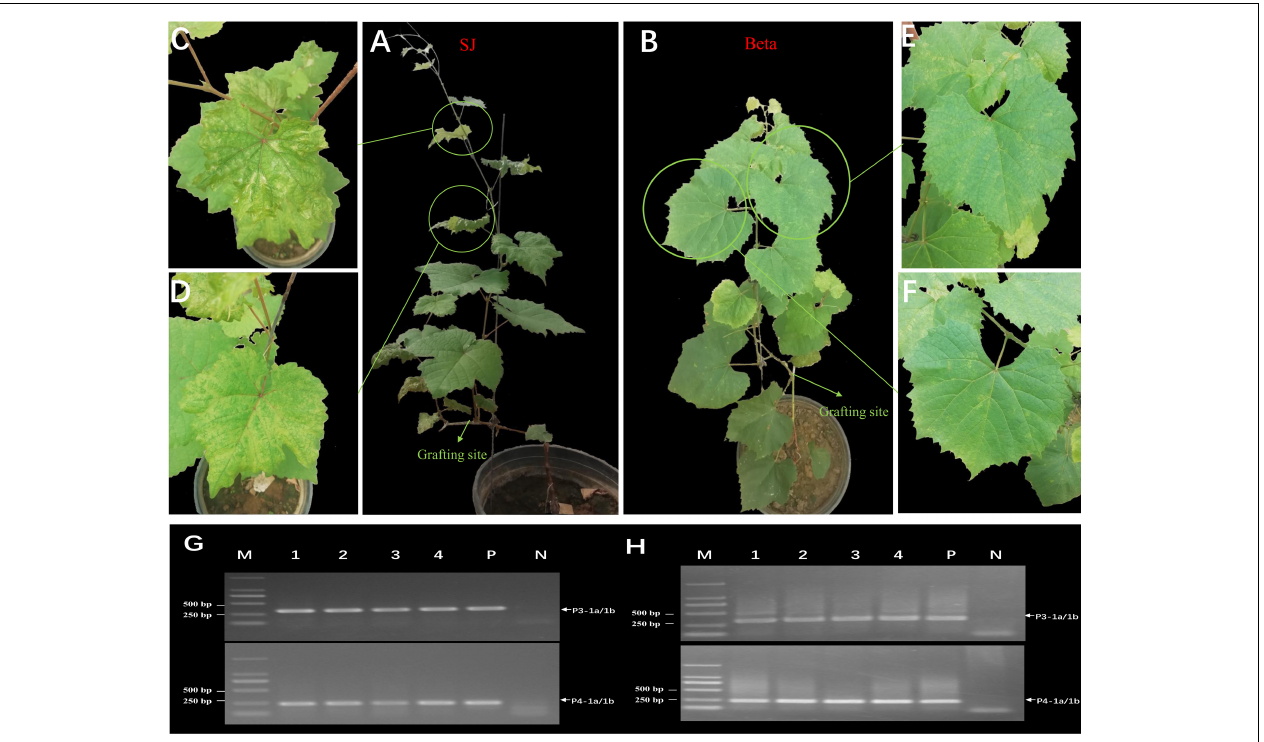
FIGURE 5 | Mechanical transmission of grapevine emaravirus A (GEVA) to grapevines. (A) Grafted “Shennong Jinhuanghou” (SJ) grapevine; (B) grafted “Beta” grapevine; Panels (C,D) partially enlarged image of panel (A) ; Panels (E,F) partially enlarged image of panel (B) . (G,H) RT-PCR detection of GEVA in grafted grapevines using two sets of primers. Lane 1–4, grafted grapevine samples; P, positive control; N, negative control; M, DNA molecular-weight marker with sizes (bp) indicated on the